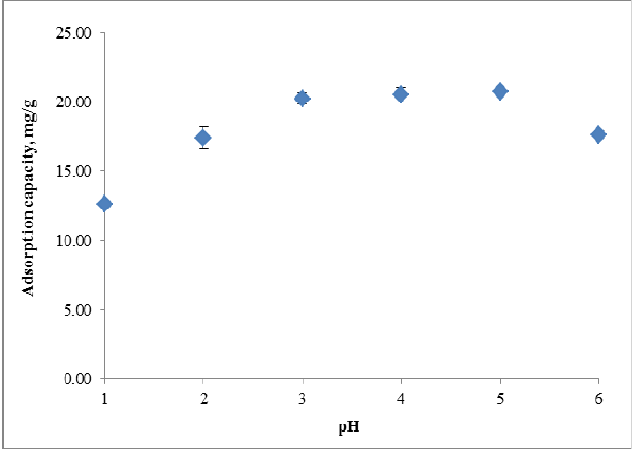
Figure 2. Adsorption capacity of peh-g-opefb towards copper ion at different pH